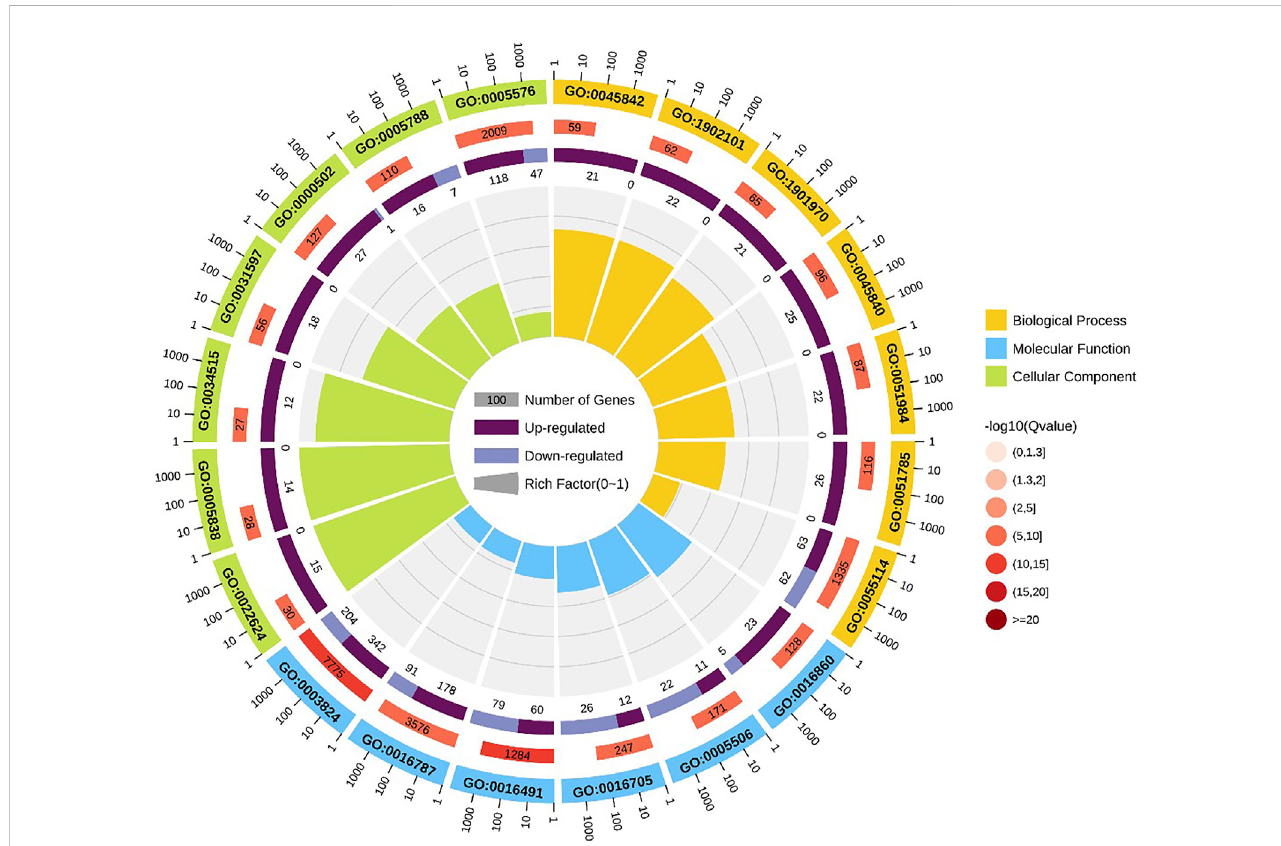
GO enrichment circle diagram of DEGs. The fi rst circle: the top 20 GO term of enrichment, and the coordinate scale of the number of differential genes outside the circle. Different colors represent different Ontology; The second circle: the number and Q value of the GO term in the background of different genes. The more the number of different gene backgrounds, the longer thebar, thesmaller the Q value and the redder the color. The third circle: bar chart of up-downdifferentialgeneproportion,deeppurplerepresentsup-downdifferentialgeneproportionandlightpurplerepresentsdown-downdifferential geneproportion;Thespeci fi cvaluesaredisplayedbelow;Thefourthcircle:RichFactorvalueofeachGotham(thenumberofdifferentialgenesinthisGotham divided by all the numbers in this Gotham), background grid lines, each grid representing